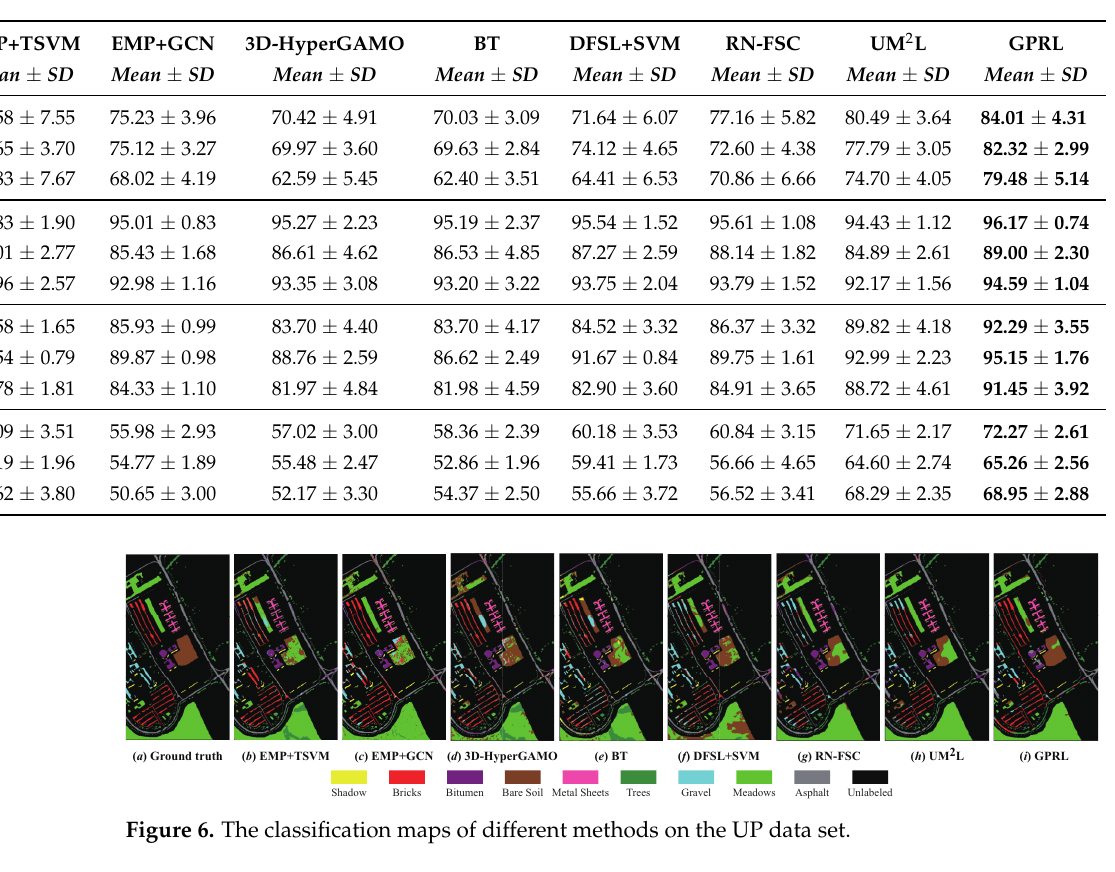
Table 2. The classification results from different methods. SD denotes the standard deviation of 10 experimental results.